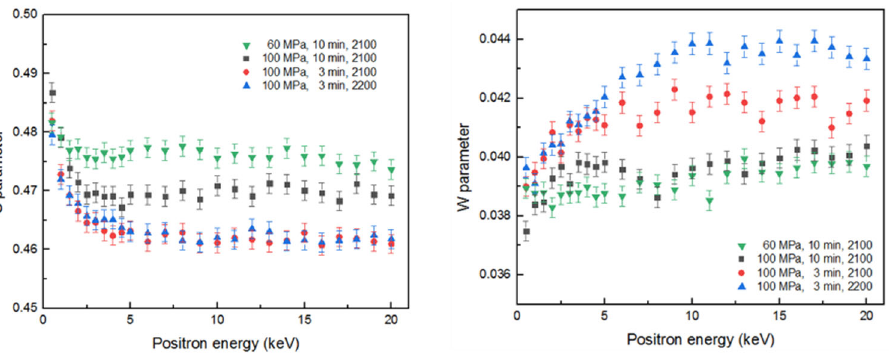
Figure 4. The dependence of line-shape S- and W-parameters of the DB spectra on the injection depth of positrons in specimens.